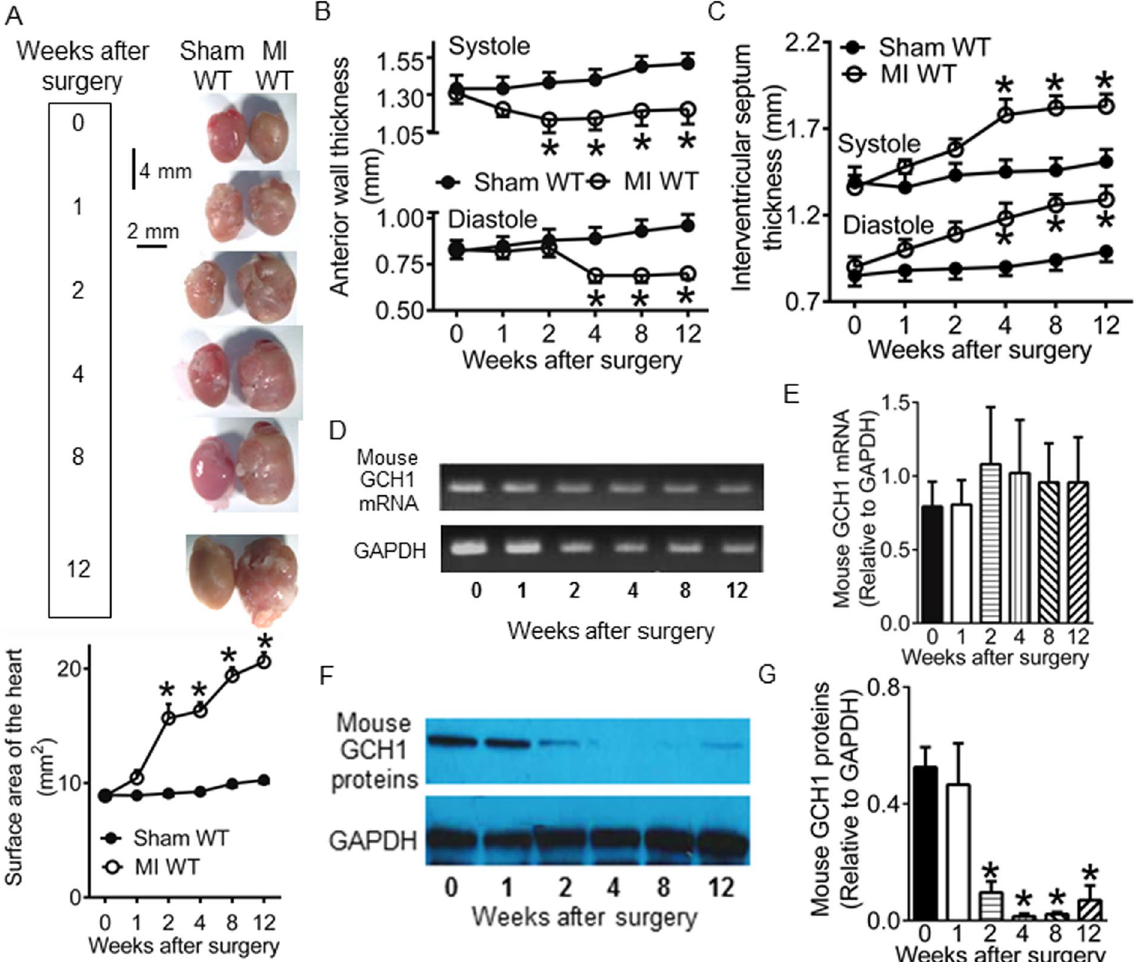
Figure 1. Wild-type (WT) mice developed cardiac remodeling and lost GTP cyclohydrolase 1 (GCH1) proteins following myocardial infarction (MI). ( A ) Time-dependent changes in mouse hearts after MI or sham surgery (n = 6–8 mice/group). Top: representative images of mouse hearts at baseline (0), 1, 2, 4, 8, and 12 weeks after operation. The vertical scale bar indicates 4 mm, and the horizontal scale bar indicates 2 mm. Bottom: the area of the hearts after MI or sham surgery; ( B ) The anterior wall thickness of the left ventricule after MI or sham surgery (n = 8–10 mice/group); ( C ) The thickness of interventricular septum following MI or sham surgery (n = 8–10 mice/group); ( D ) Representative PCR bands showing the expression of GCH1 mRNA and the housekeeping gene, glyceraldehyde 3-phosphate dehydrogenase (GAPDH), at 0, 1, 2, 4, 8, and 12 weeks after MI; ( E ) GCH1 mRNA normalized to GAPDH (n = 6 mice/group); ( F ) Representative Western blot bands showing the expression of cardiac mouse GCH1 proteins and GAPDH proteins in WT mice following MI; ( G ) Expression of mouse GCH1 proteins normalized to GAPDH proteins (n = 6 mice/group). * P < 0.05 versus sham WT groups at corresponding time points ( A , B and C ) or 0 weeks ( G